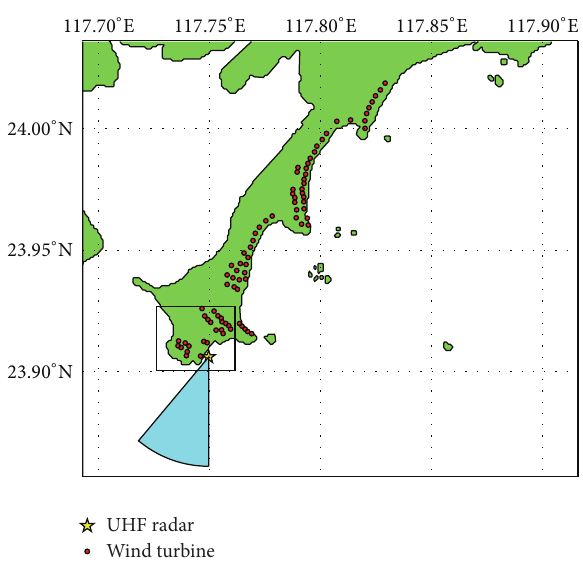
Figure 1: Location of wind turbines and UHF